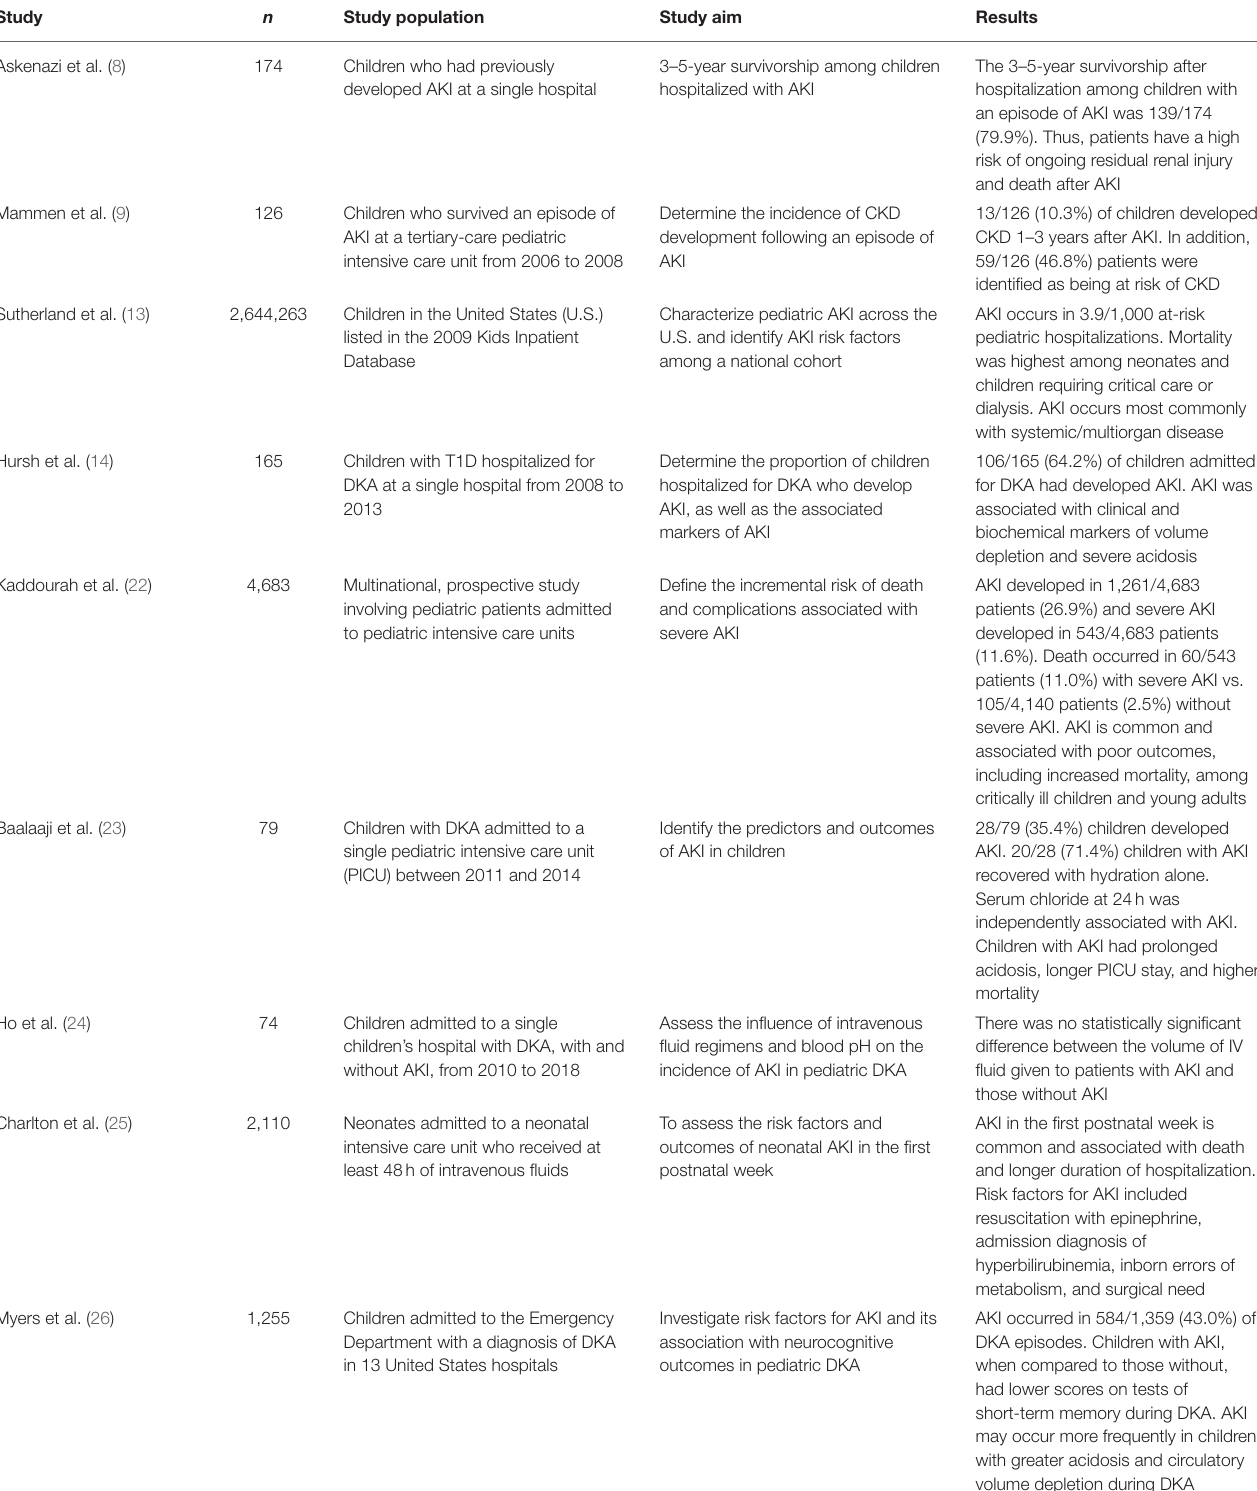
TABLE 1 | Studies on AKI in pediatric populations with and without